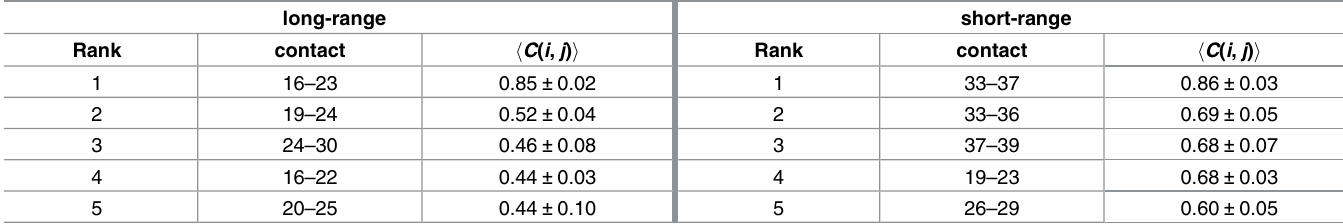
Table 4. Five top side chain contacts in A β 10-40peptide for C22 * force